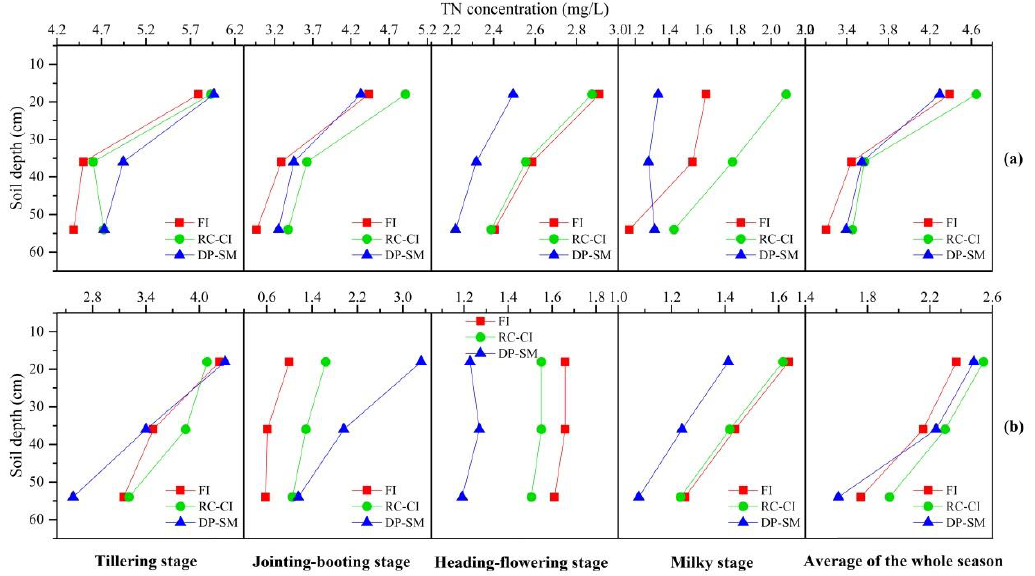
Figure 6. Vertical change of TN concentration in soil water at the depth of 18, 36 and 54 cm in ( a ) 2017 and ( b ) 2018.